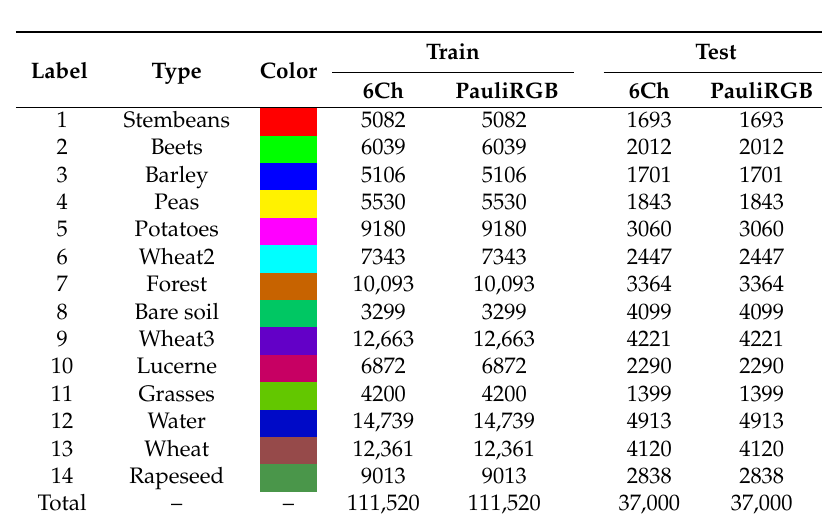
Table 1. The detailed information of the training set and testing set on 14 types of land cover classes on Flevoland PolSAR